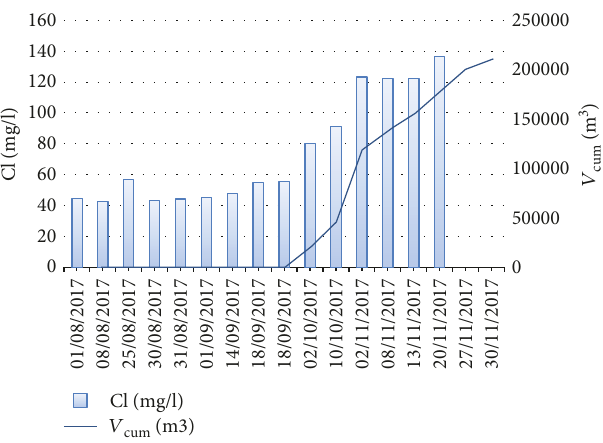
Figure 6: Comparison between the Cl concentration and water cumulated volume of the Tulliola well.